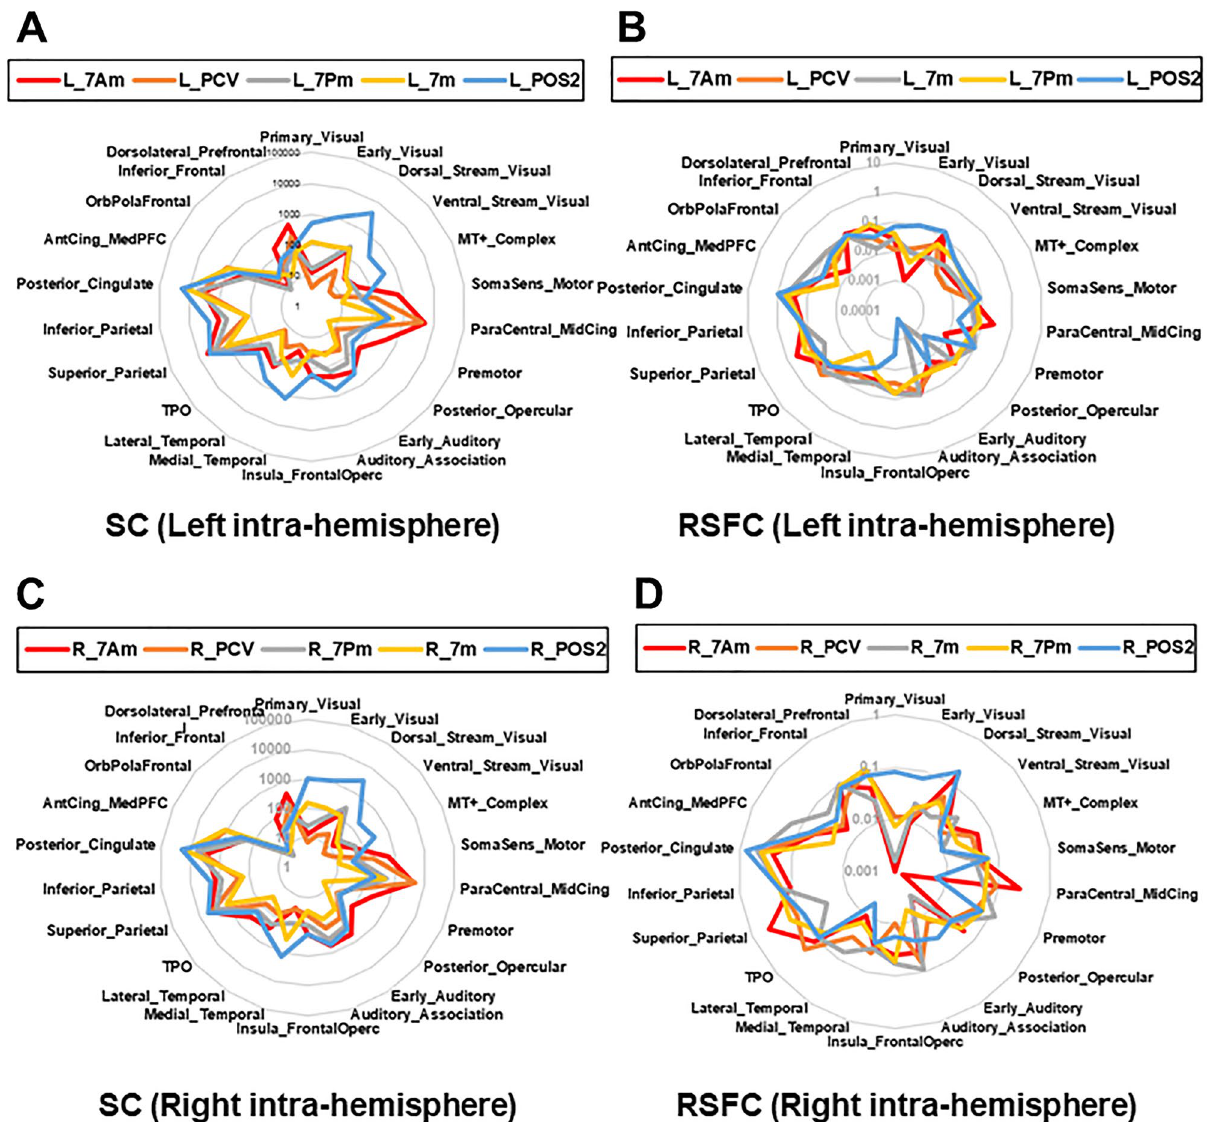
Figure 4. Radar plots showing the connectional profile of SC and RSFC in the left and right hemisphere. ( A , B ) Radar plot showing the intra-hemispherical group-average connectional profile of the SC ( A ) and the RSFC ( B ) between each precuneus ROI (7Am, PCV, 7Pm, 7m, POS2) and the 22 Cortical Divisions in the left hemisphere, respectively. ( C , D ) Radar plots showing the intra-hemispherical group-average connectional profile of the SC ( C ) and the RSFC ( D ) in the right hemisphere, respectively. Scale; SC (streamline count/area), RSFC (Fisher’s z transformed pairwise correlation converted to Log scale). The details of 22 Cortical_Divisions in HCP MMP atlas are shown in Supplementary Fig.